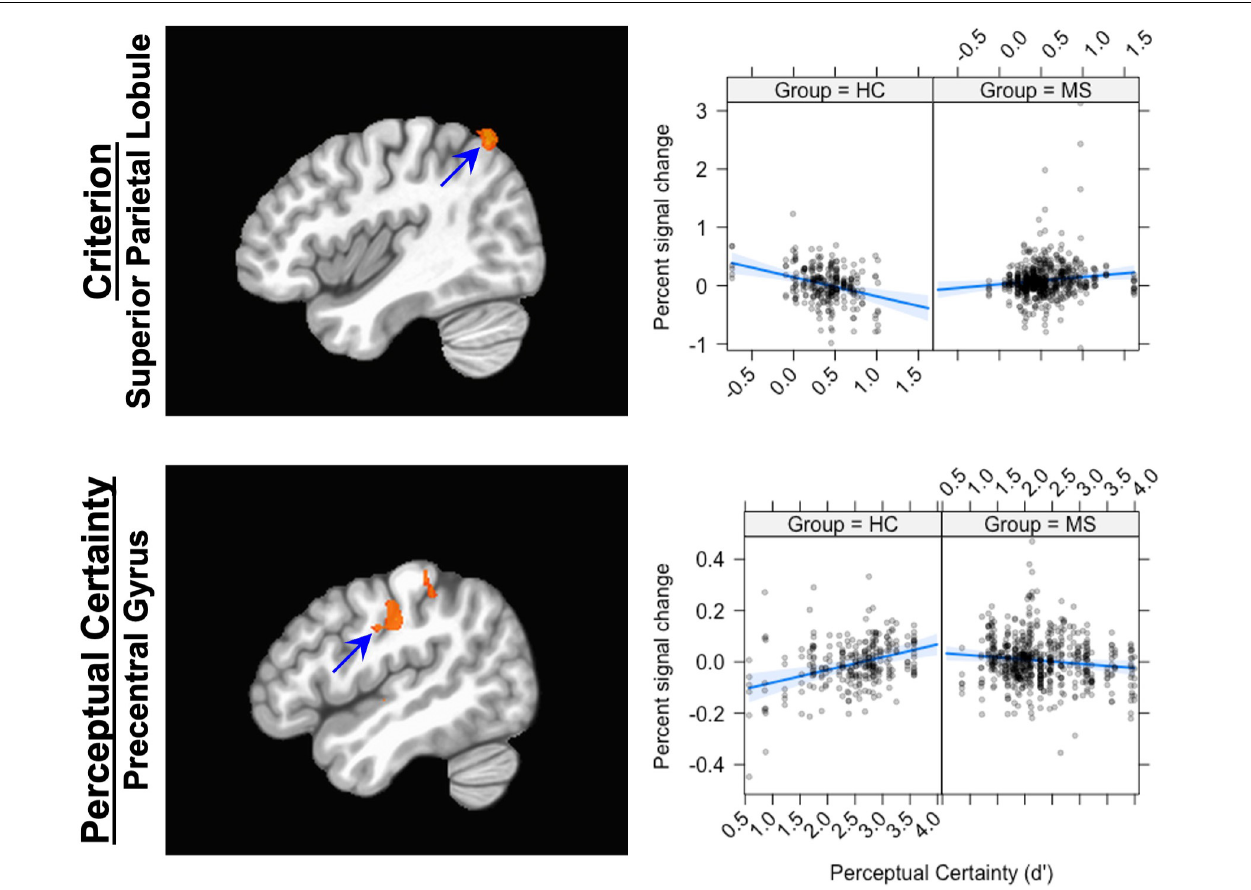
FIGURE 3 | The Group × Criterion interaction (top row) and the Group × d’ interaction (bottom row). The panel on the left shows the location of the interaction; the panel on the left shows graphs of the interaction. For the Group × Criterion interaction, the location plotted is (X, Y, Z = 42, –63, 58); for the Group × d’ interaction, the location is (X, Y, Z = –50, –19, 38). The scatterplots show the relationship between Percent signal change (ordinate) and Criterion (abscissa, top) and Perceptual Certainty (abscissa, bottom). The blue line shows the best fitting linear trend and the blue shaded area shows the 95% confidence